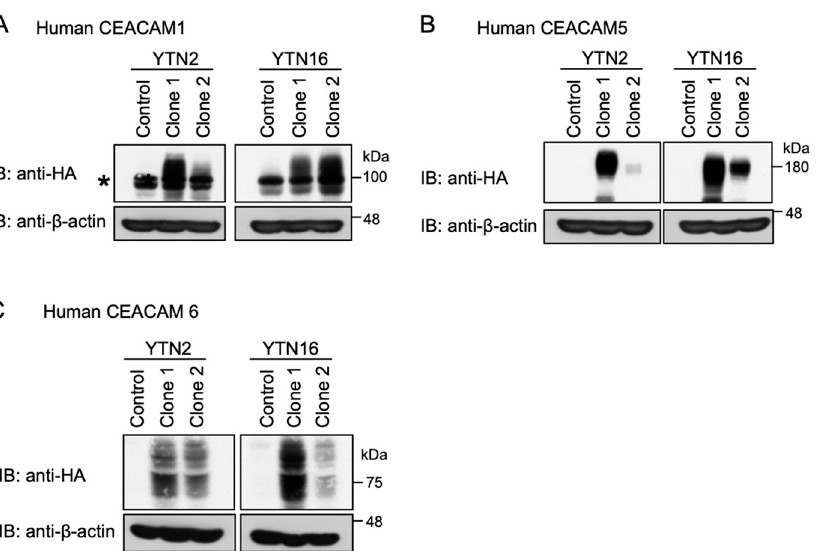
Figure 3. Establishment of human CEACAM-expressing mouse gastric epithelial cells. ( A ) YTN2- and YTN16-derived hemagglutinin (HA)-tagged human CEACAM1 stable cells (clone 1 and clone 2) were harvested and analyzed for expression. Parental cell lines were used as control. The asterisk (*) denotes the non-specific band observed by immunoblotting of YTN2 and YTN16 mouse cell lysates with a human CEACAM1 antibody. ( B ) YTN2- and YTN16-derived HA-tagged human CEACAM5 stable cells (clone 1 and clone 2) were harvested and analyzed for expression. Parental cell lines were used as control. ( C ) YTN2- and YTN16-derived HA-tagged human CEACAM6 stable cells (clone 1 and clone 2) were harvested and analyzed for expression. Parental cell lines were used as control. CEACAMs are recognized as broad bands as they are heavily glycosylated in the cells.